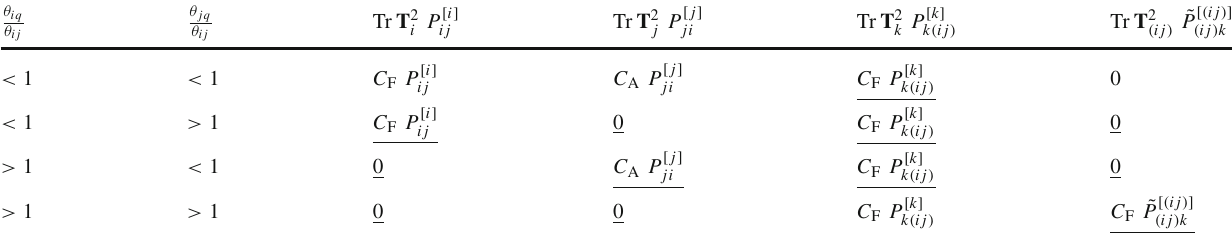
Table 1 The contributions to Eq. (9), the azimuthally-averaged squared matrix element in the limit θ ij (cid:3) θ ik . Terms where wide-angle, soft